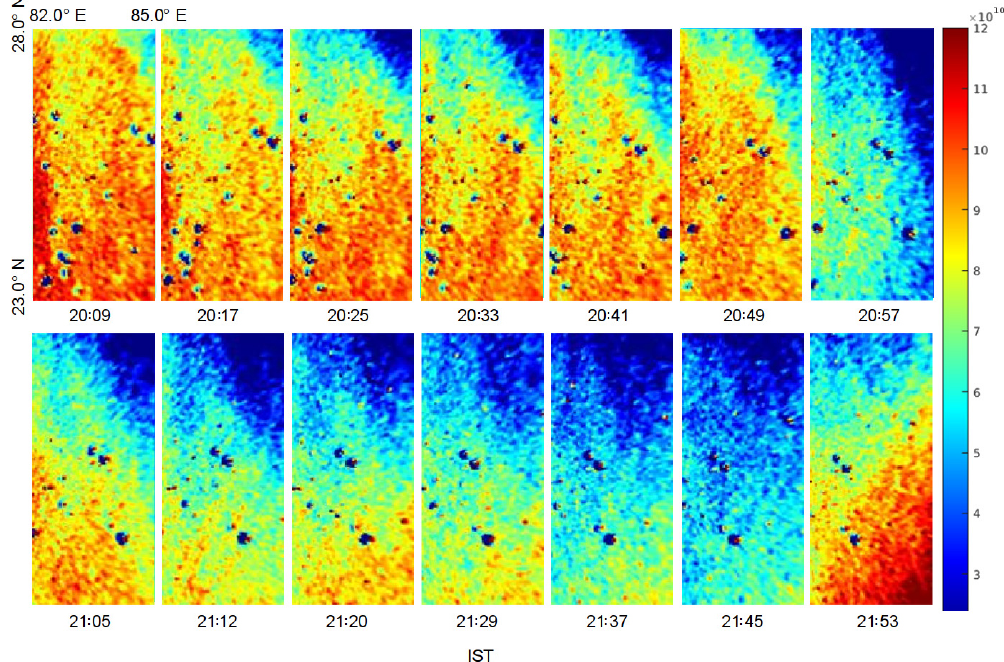
Figure 8. Sequence of airglow-derived Nm maps during 20:00–22:00IST on 9 January 2016 (Nm is expressed in m − 3